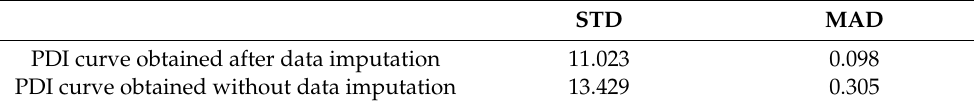
Table 5. Criteria of different procedures.